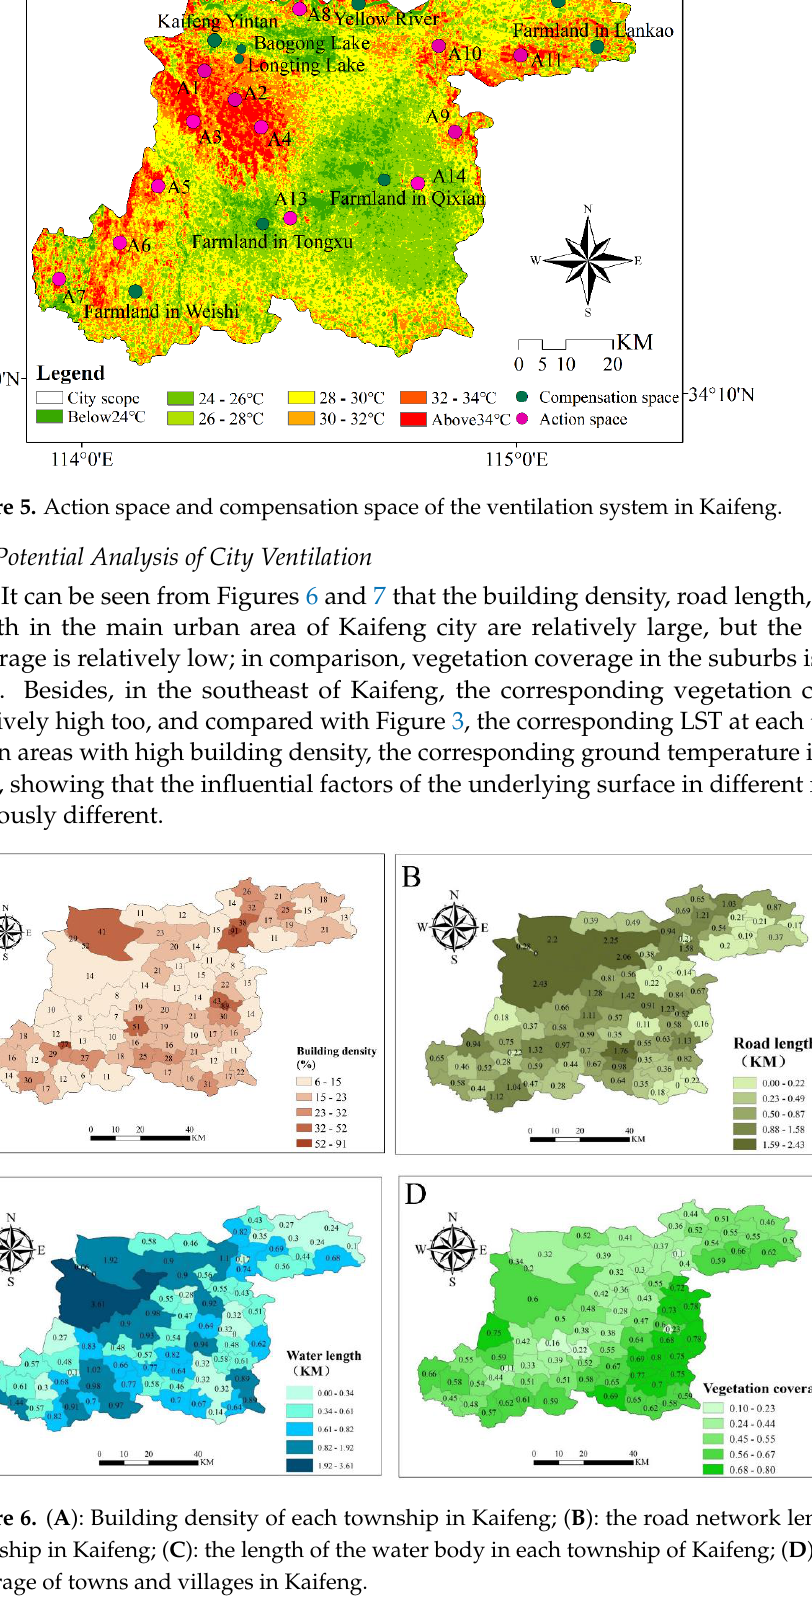
Figure 7. Line chart of each influential factor. ( A ): building density; ( B ): road network length; ( C ): water body length; ( D ): vegetation coverage. Furthermore, as shown in Figure 8, in the comprehensive impact factor analysis dia- gram, the darker color refers to a higher ventilation potential, and the lighter color indi- cates an area that is less conducive to the circulation of urban wind. It can be seen that the southern part of Kaifeng’s main urban area has good ventilation potential, while the northern part has relatively weak ventilation potential. This is because there are a large number of water bodies and accessible road networks in the southern part of the main urban area of Kaifeng, and the corresponding areas of the Yellow River, Kaifeng Yintan, Longting Lake, and Baogong Lake also have good ventilation potential. In addition, from Figures 5 and 8, although the ventilation potential value of Kaifeng in the northern part is better than that in the southern part, the temperature in the north is higher than that in the south. This is because the main urban area is in the north of Kaifeng, with high build- ing density and dense traffic. However, the southern part is the suburbs and farmland of Kaifeng, and water and vegetation are abundant, which effectively absorb the heat gener- ated by solar radiation to achieve a cooling effect. Therefore, it can be inferred that to reduce the surface temperature of the city, the role of the road network, water, and vegetation should be exerted. It is further known that when designing urban air ducts or improving the urban microclimate, the thermal and dynamic forcing of this underlying surface should be used.